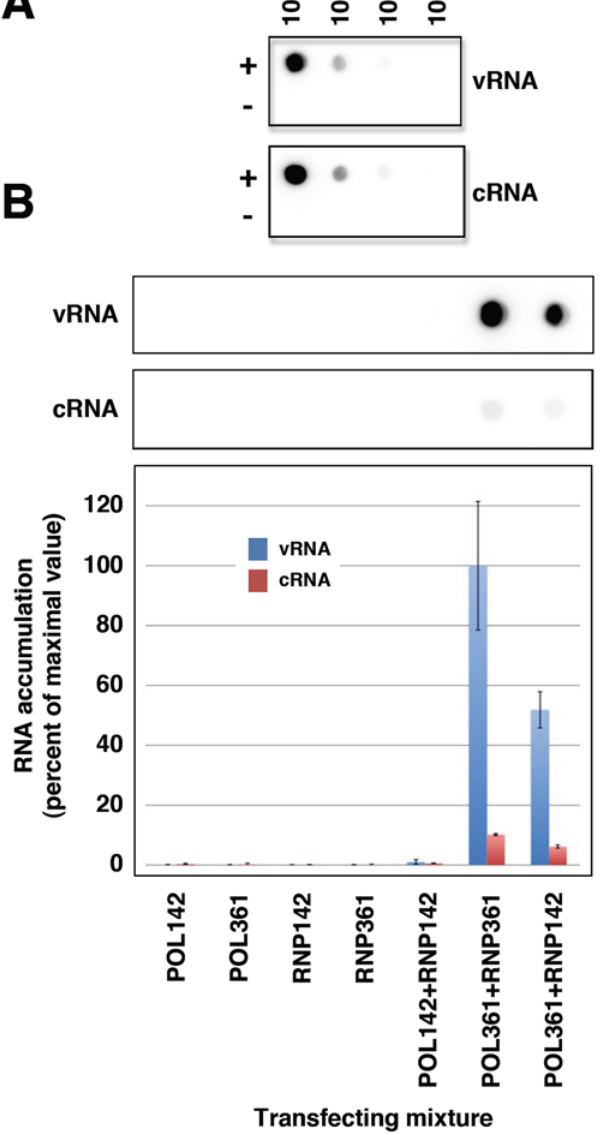
Figure 4. Analysis of the genomic RNA present in purified RNPs. Cultures of HEK293T cells were transfected with plasmids expressing the NP and various combinations of the polymerase subunits and purified RNPs containing either replication-deficient or transcription-deficient polymerase, as indicated in the diagram of Fig. 3A. The purified progeny RNPs were purified from total cell extracts by affinity chromatography over Ni 2 + -NTA-agarose and the RNA present in the purified RNPs was extracted as described under Materials and Methods. (A) Hybridisation controls. Dilutions of plasmid pHH D NS clone 23, containing the sequence of the RNP replicons used ( + ), or total yeast RNA ( 2 ) were applied onto a nylon filter as hybridisation controls (from 10 3 to 10 0 ng, as indicated at the top of the figure). Hybridisation was performed using a positive-polarity or a negative-polarity probe comprising the full-length insert present in pHH D NS clone 23, thereby detecting either vRNA or cRNA, respectively. (B) Aliquots of the RNA present in purified RNPs obtained from cultures transfected with the mixtures indicated at the bottom of the figure were hybridised in parallel to the hybridisation controls shown in (A) and the hybridisation signals were quantitated in a phosphorimager, using the signals in (A) to standardise the relative hybridisation efficiency of the positive- and negative-polarity probes. The results for vRNA (blue) and cRNA (orange) are presented as percent of the maximal signal and represent the averages and standard deviations of 4 quantisations.